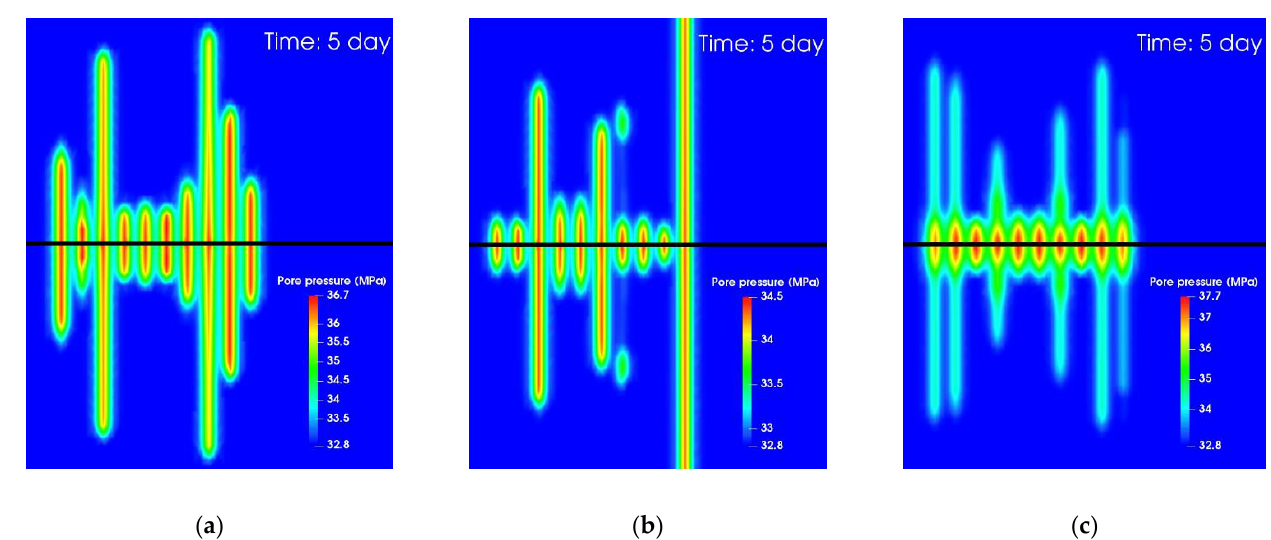
Figure 14. Pore pressure distribution on a horizontal slice through the wellbore after the shut-in period. ( a ) Case using slick water, ( b ) Case using NG foam, ( c ) Case using hybrid NG and NG foam.